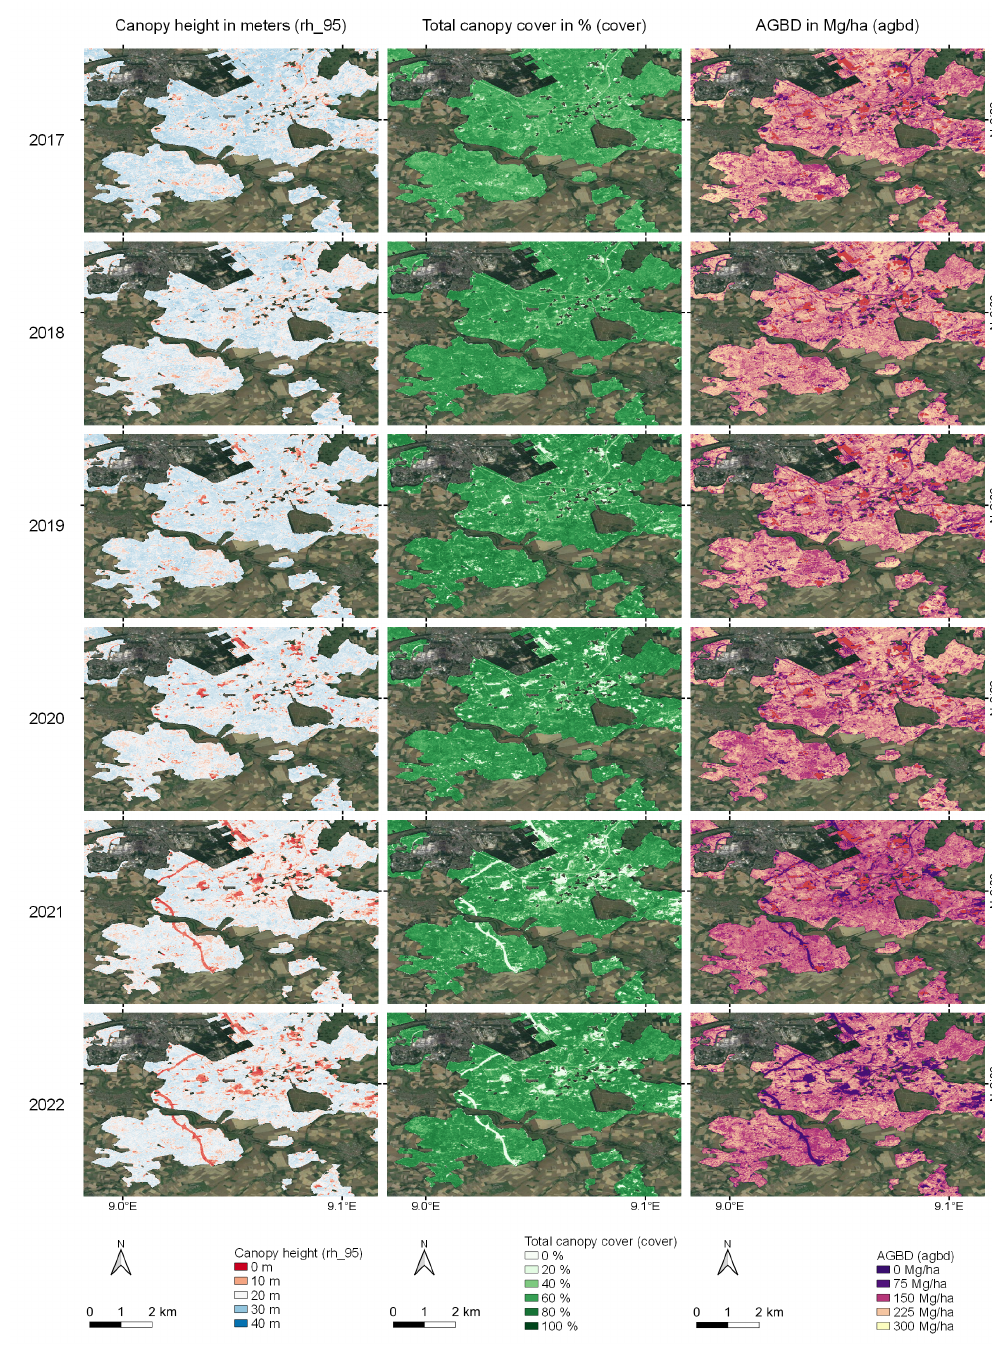
Figure 12. Forest structure change in the Dannenröder Forst (2017 to 2022). Rather stable conditions until 2020 are followed by logging activities resulting forest loss and forest fragmentation for the construction of the highway